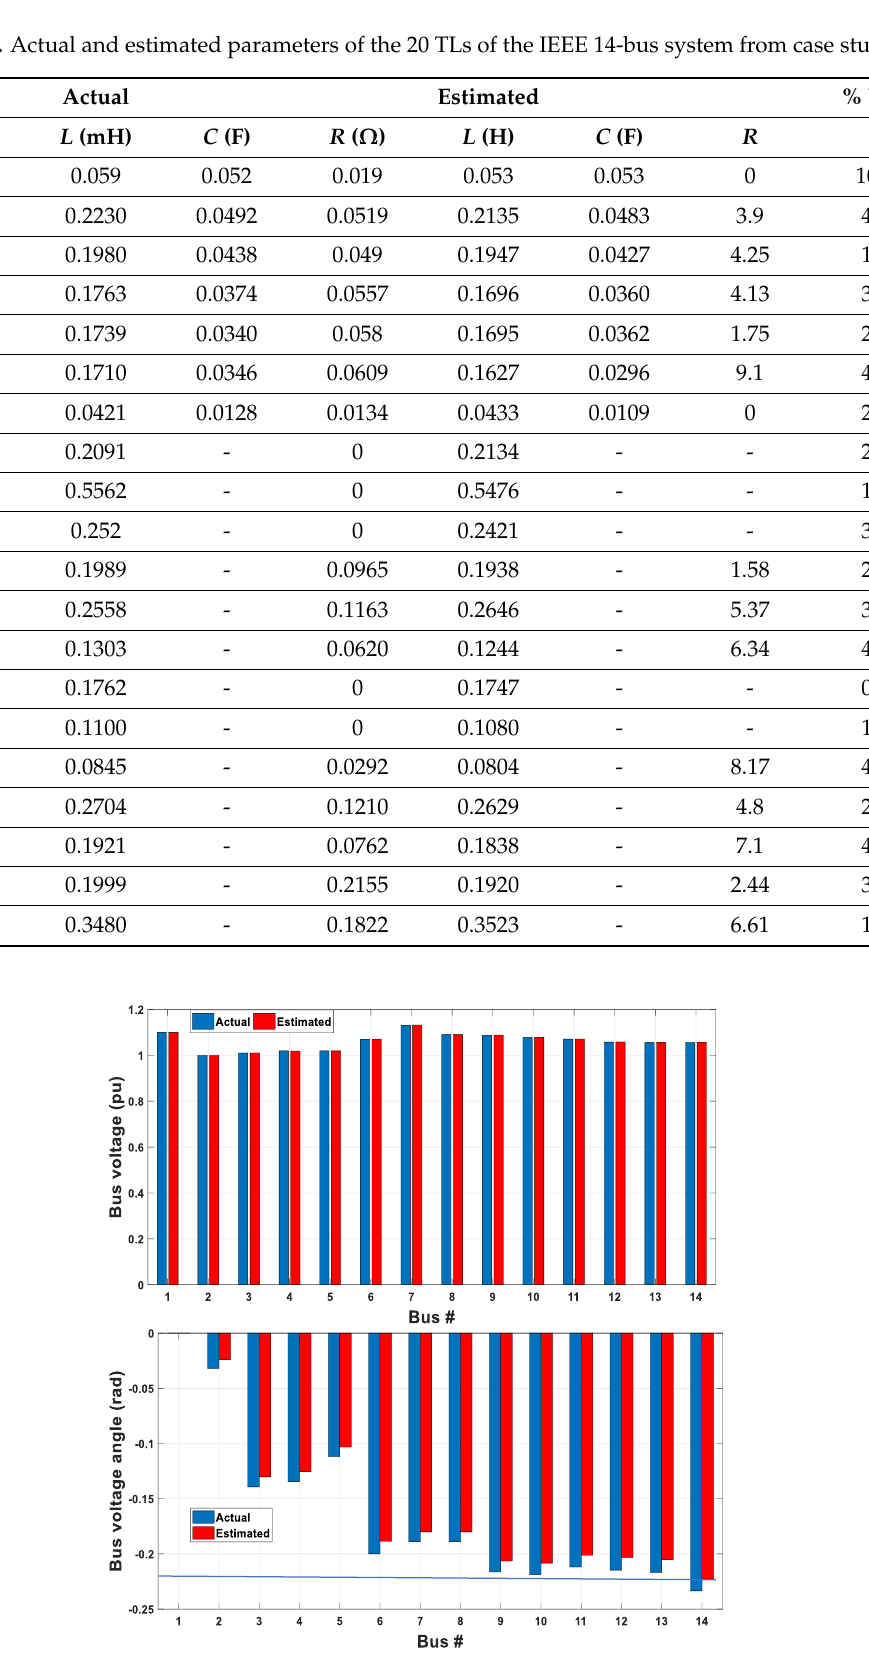
Figure 8. Bus voltages (magnitude and phase angle) of the IEEE 14-bus system from case study-3.